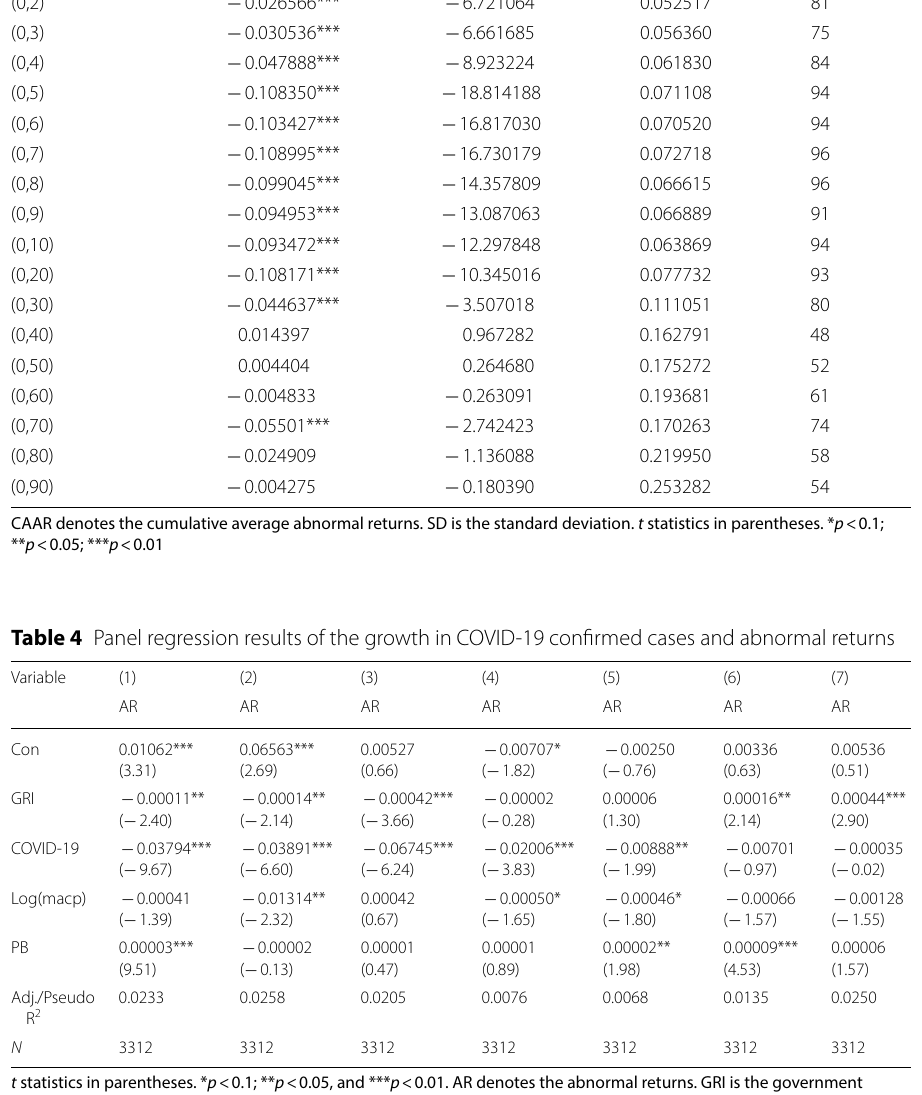
t statistics in parentheses. * p < 0.1; ** p < 0.05, and *** p < 0.01. AR denotes the abnormal returns. GRI is the government response index obtained from Oxford COVID‑19 Government Response Tracker. COVID‑19 represents the daily growth rate of COVID‑19 confirmed cases calculated as (( Case t − Case t − 1 )/ Case t − 1 ) . Logmacp is the logarithm of market capitalization. PB represents the price‑to‑book ratio. Columns (1) and (2) show the results of pooled OLS and fixed‑effects, respectively. Columns (3)–(7) represent the quantile regression results with five quantiles q